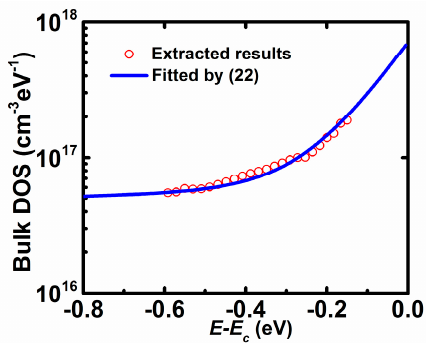
Figure 7. Extracted bulk DOS as a function of E − E C from the proposed method (symbols) and results fitted by (22) (solid lines).